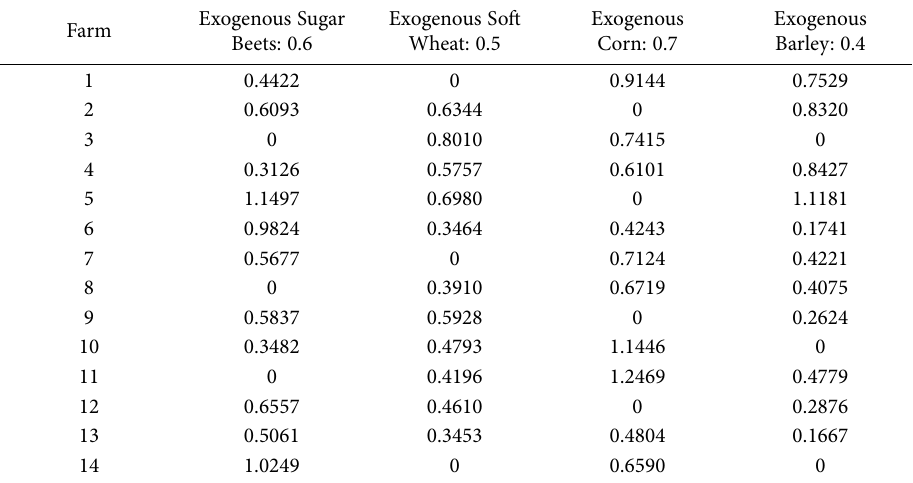
Table 10. Disaggregation/aggregation of the regional, exogenous own-supply elasticities with zero observations of some output